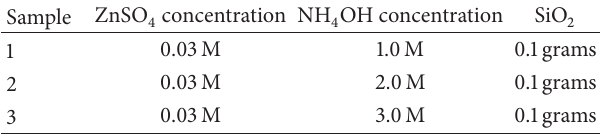
Table 1: List of parameters of solution used for ZnO-SiO 2